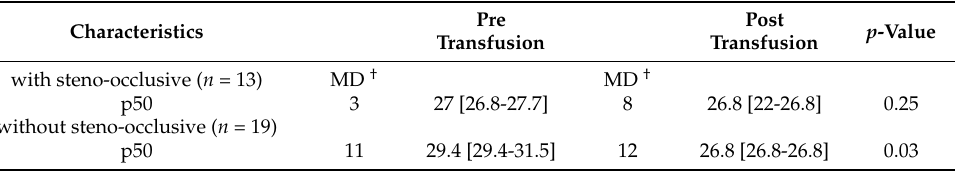
Table A1. Main biological variables from patients with SCD according to their cerebral steno-occlusive arterial disease status. Quantitative data were expressed as medians [interquartile ranges, IQRs]. The nonparametric Wilcoxon test was used as appropriate. p -values < 0.05 were considered statistically significant. † Missing data